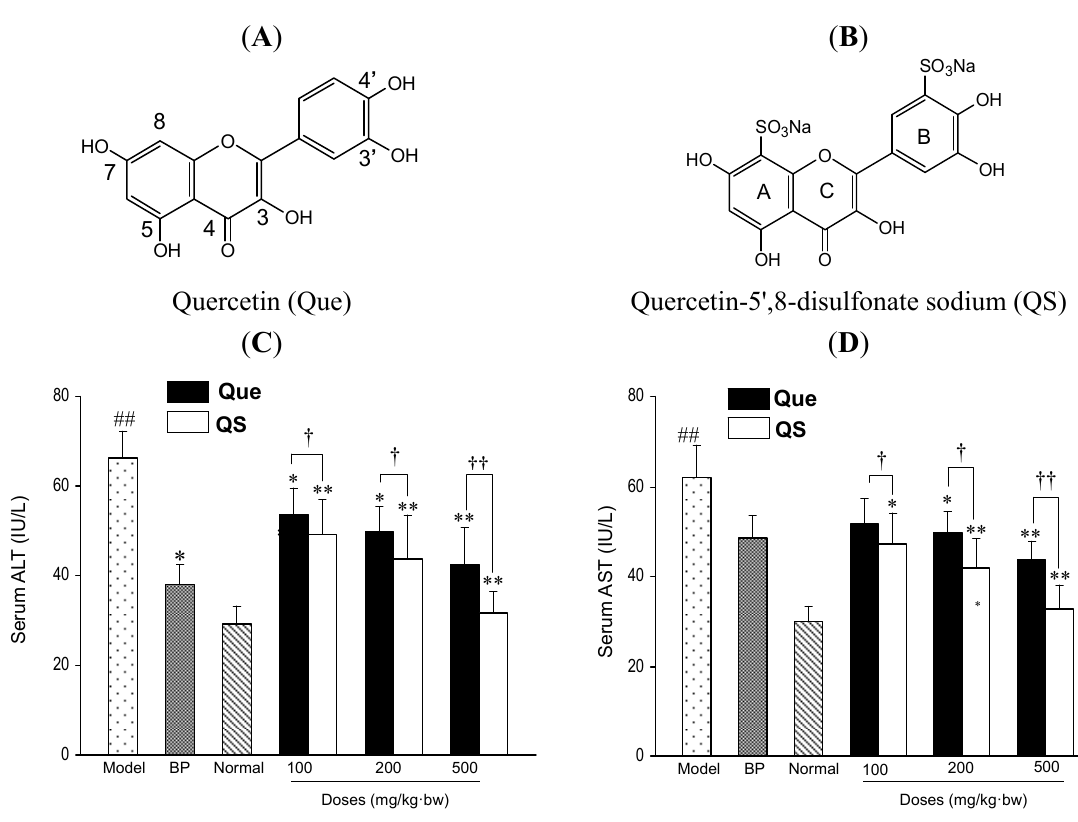
Figure 1. The chemical structures of quercetin (Que) ( A ) and quercetin-5',8-disulfonate (QS) ( B ). Effects of Que and QS on serum enzymic activities of ALT ( C ) and AST ( D ) of mice after CCl treatment. Mice were treated intragastrically with Que or QS (100, 200 and 4 500 mg/kg·bw) once daily for fourteen consecutive days prior to the single administration of (0.1%, ip). Data were expressed as mean ± SD. # p < 0.05, ## p < 0.01, compared to the CCl 4 normal group. * p < 0.05, ** p < 0.01, compared to the CCl and †† p < 0.01 versus the corresponding dose of Que